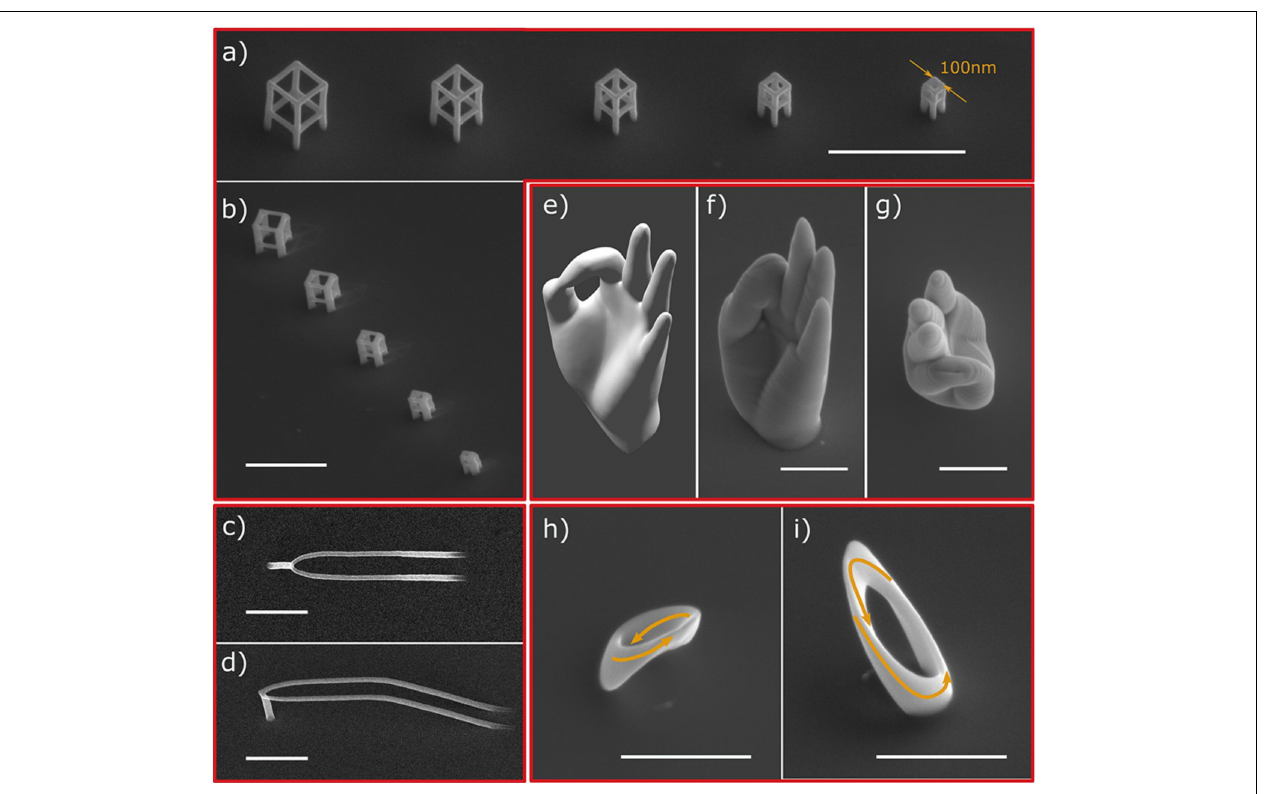
FIGURE 7 | SEM images of different 3D geometries prepared by the focused electronbeam-induced deposition (FEBID) method. (a,b) A series of cubes. (c,d) Smooth nanowires. (e–g) Nanoscale replica of a human hand. (h,i) Cobalt Mobius strip (Skoric et al.,